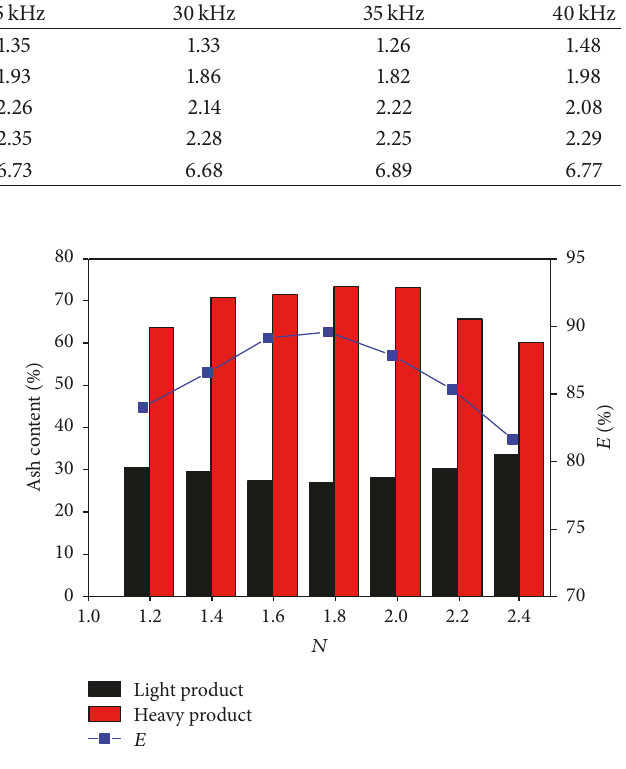
Figure 2: Separation results at different vibration frequency. Figure 3: Separation results at different fluidization